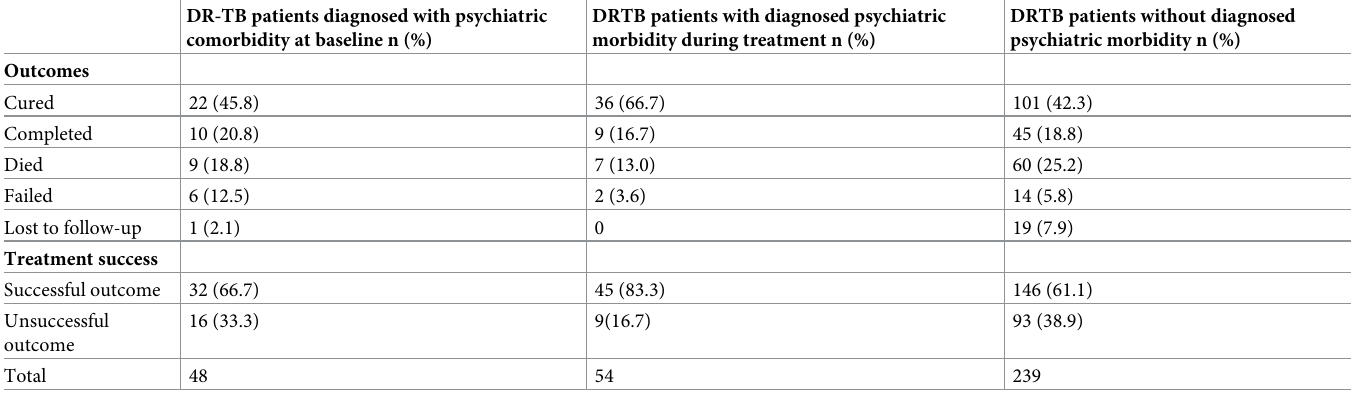
Table 4. TB treatment outcomes among drug-resistant tuberculosis patients enrolled at MSF Mumbai clinic between January 2012 and March 2019. DR-TB patients diagnosed with psychiatric DRTB patients with diagnosed psychiatric comorbidity at baseline n (%) morbidity during treatment n